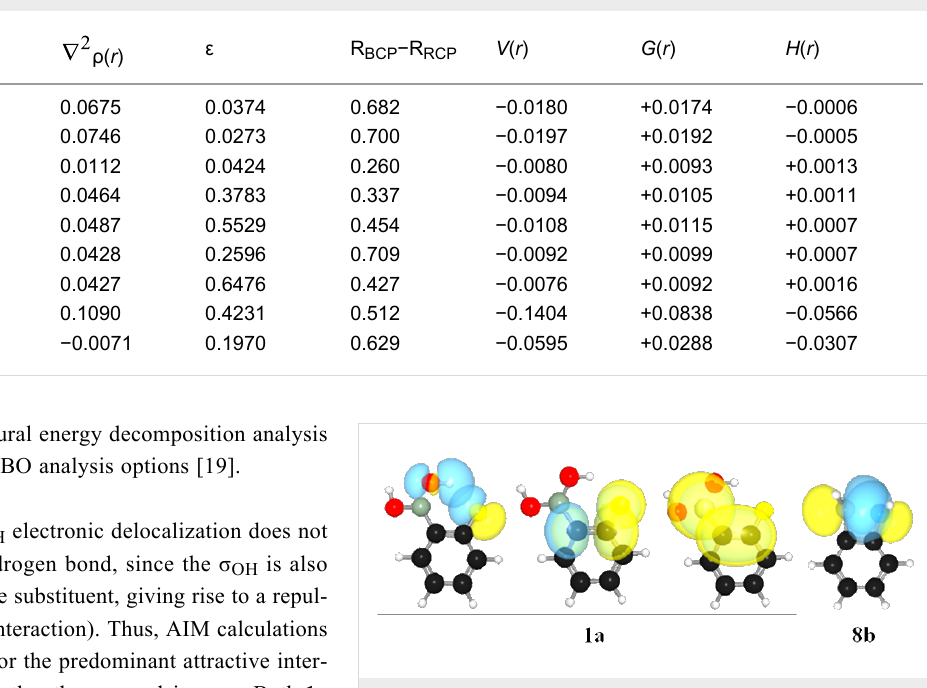
Figure 3: Important hyperconjugative interactions for 1a (from the left to the right: n F →σ * OH , n F →π * CC and π CC → p B ) and 8b (n N → p B ) obtained by NBO